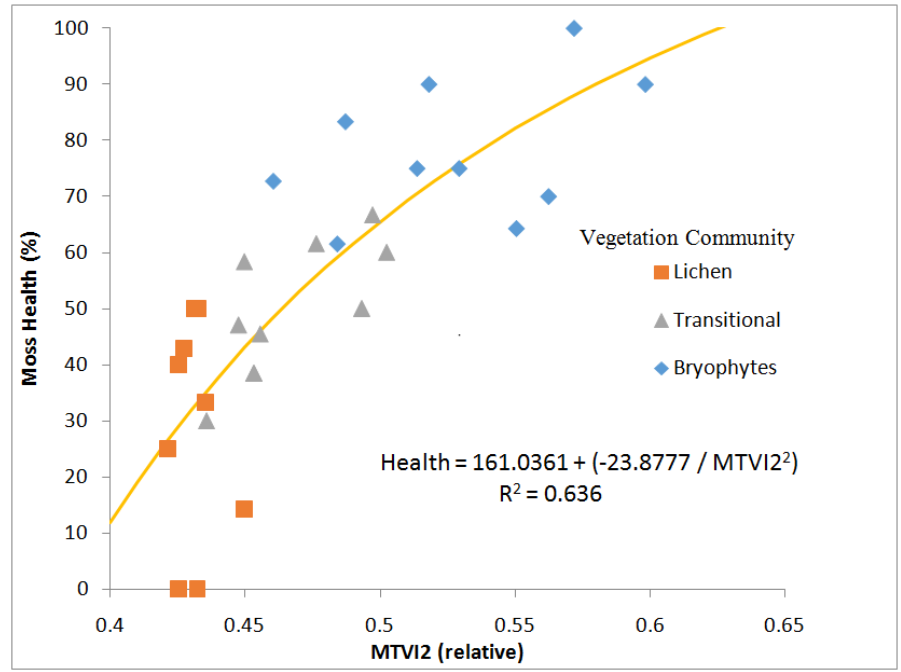
Figure 5. Statistical relationship between the ground-measured moss health and the MTVI2 index computed from mosaic of multispectral mini-MCA images obtained at Robinson Ridge test